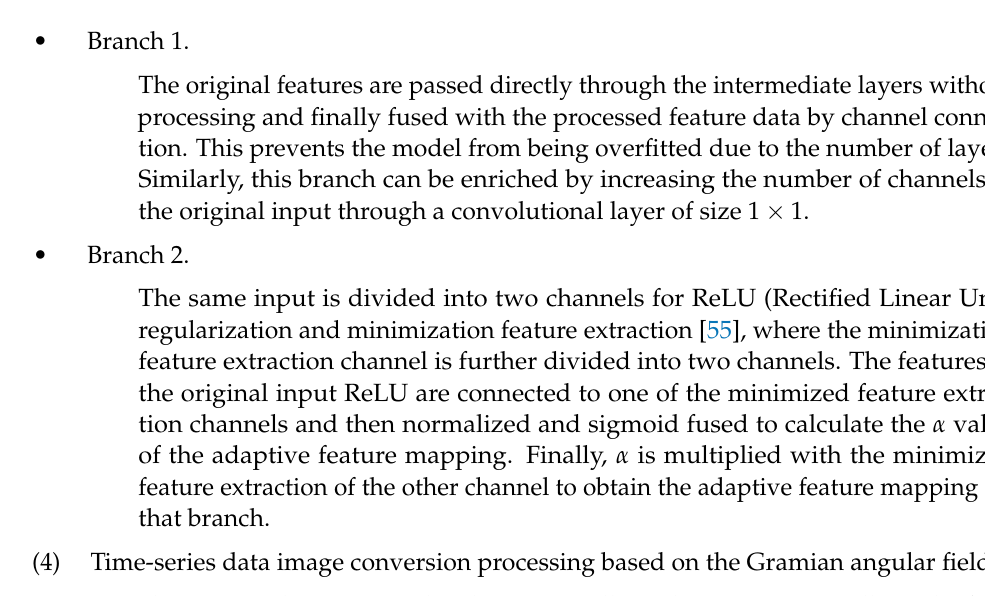
Figure 6. Structure of the feature adaptive mapping